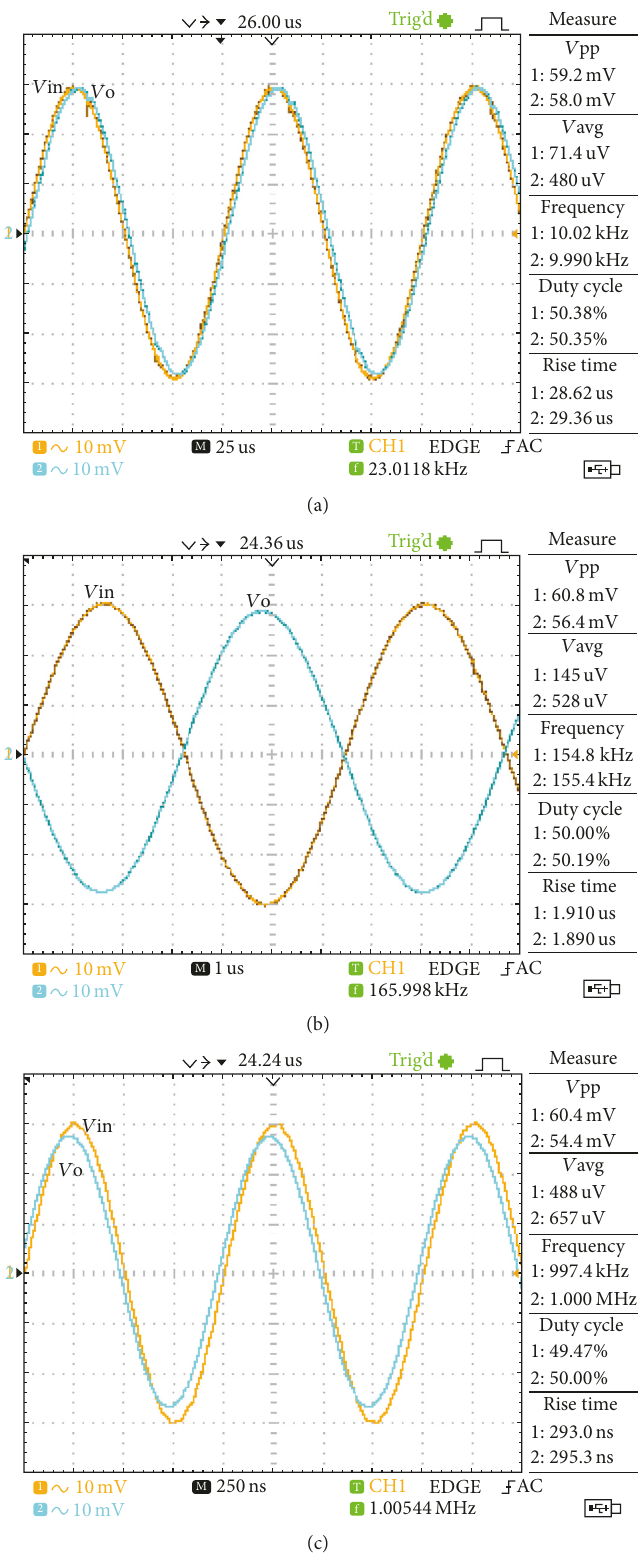
Figure 9: The measured input and output waveforms of all-pass filter at (a) 10 kHz, (b) 155 kHz, and (c)